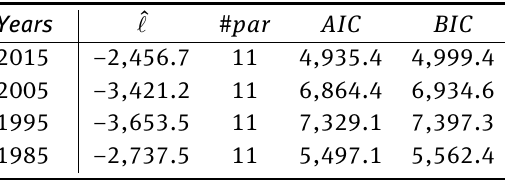
Table 4: Maximum log-likelihood, number of parameters, values of the Akaike and Bayesian information criteria of the latent class models with two latent classes selected for the data collected at each